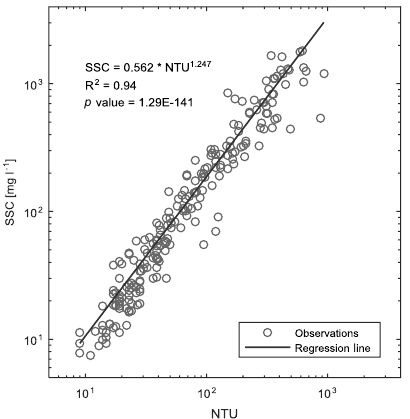
Figure 3. Scatter plot of NTU and SSC observed simultaneously (i.e. with a maximum lag of 5min) at the outlet of the catchment (grey circles), and calibrated regression line of Eq. (1) (black